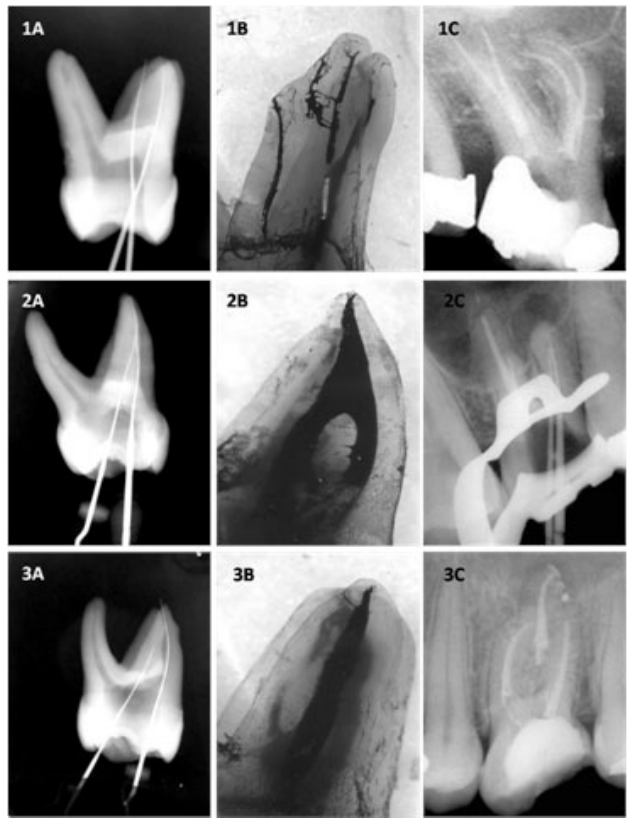
Fig. 3. Examples of simplified classification. (1A) Laboratory radiograph of a Type I tooth; (1B) Clearing of a Type I tooth; (1C) Clinical radiograph of a Type I tooth; (2A) Laboratory radiograph of a Type II tooth; (2B) Clearing of a Type II tooth; (2C) Clinical radiograph of a Type II tooth; (3A) Laboratory radiograph of a Type III tooth; (3B) Clearing of a Type III tooth; (3C) Clinical radiograph of a Type III